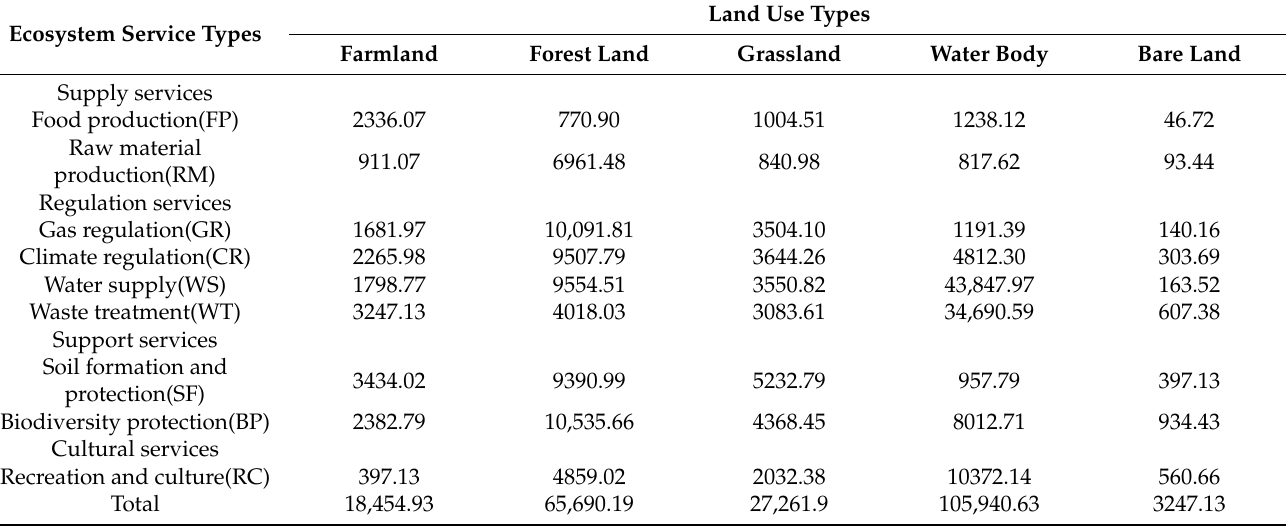
Table 1. ESV equivalent factor tables for different land use types in SCBJ (CNY/hm 2